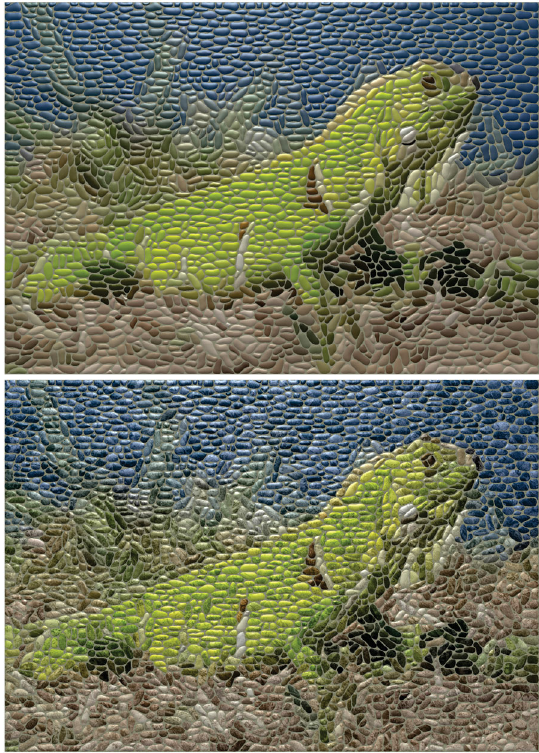
Fig. 9 Above: result without texture. Below: textured